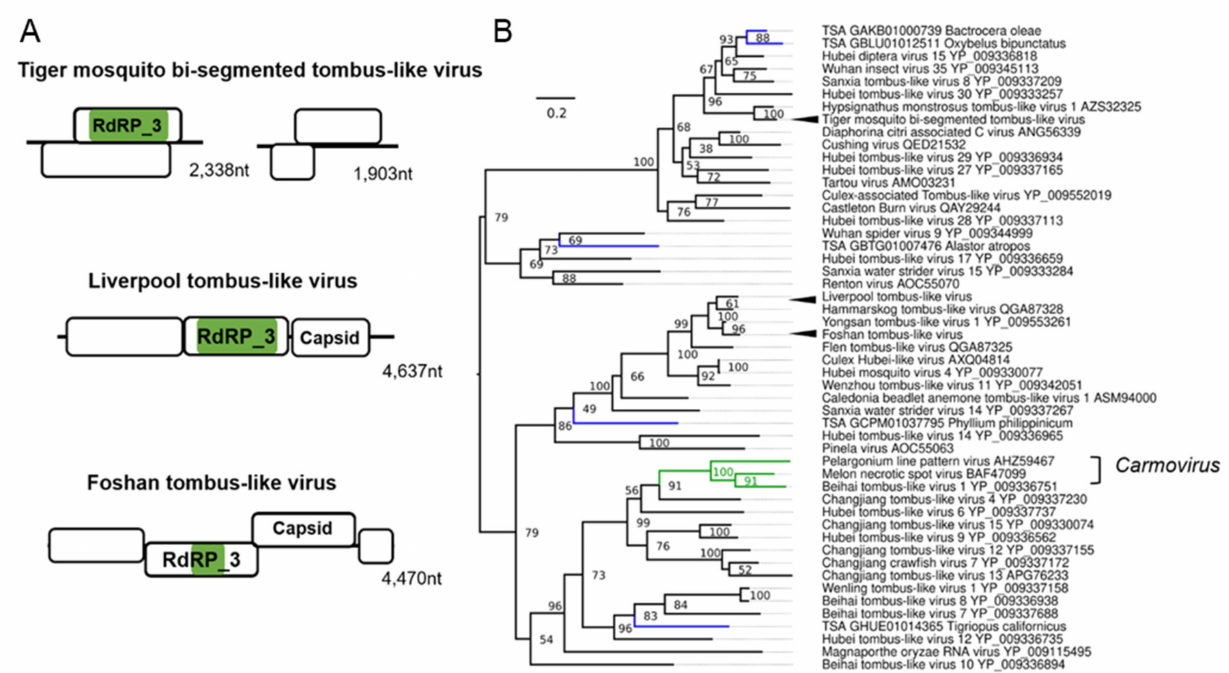
Figure 5. Novel positive-sense RNA viruses of Ae. albopictus and Ae. aegypti. Genome organisation of novel tombus-like viruses identified in this study ( A ) and phylogenetic placement ( B ) of viruses from aligned RdRp3 domains. Consensus maximum-likelihood trees were made using IQTree with the LG + G4 amino acid substitution model with 50,000 Ultrafast bootstraps with bootstrap support labelled on the node. Each TSA accession is shown in blue, members of the Carmovirus genus are indicated in green. Novel viruses are indicated with arrowheads. Branch length indicates the number of amino acid substitutions per site. For clarity, the tree is midpoint